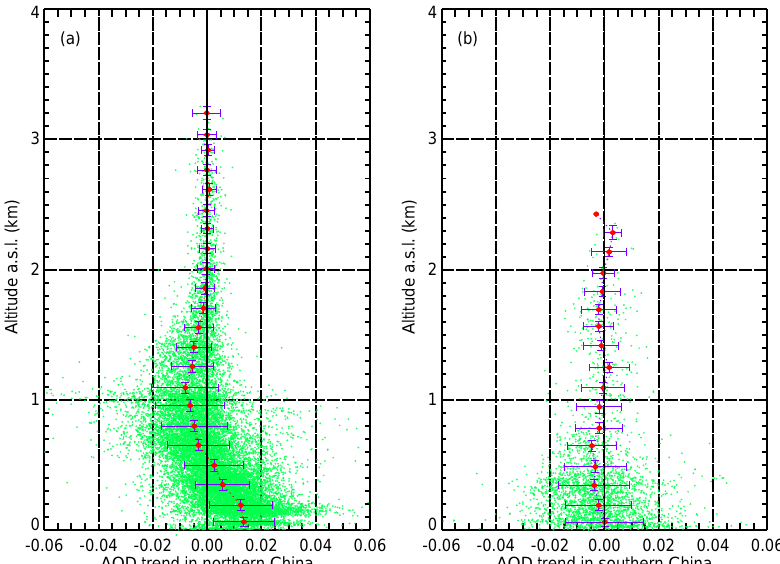
Figure 9. Vertical distributions of the trend in AOD from MODIS-Aqua in (a) northern ( > 40 ◦ N) and (b) southern ( < 30 ◦ N) China from 2002 to 2014. The specific region of study can be found in Fig. S3.